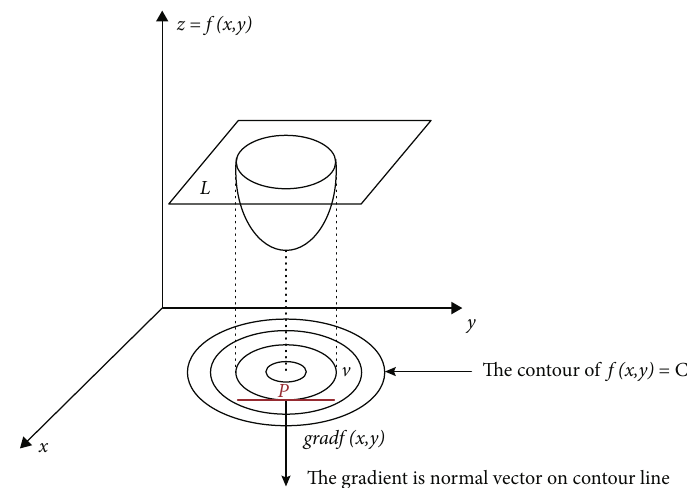
Figure 3: The relationship between the gradient at a point on the surface and the isoline through this